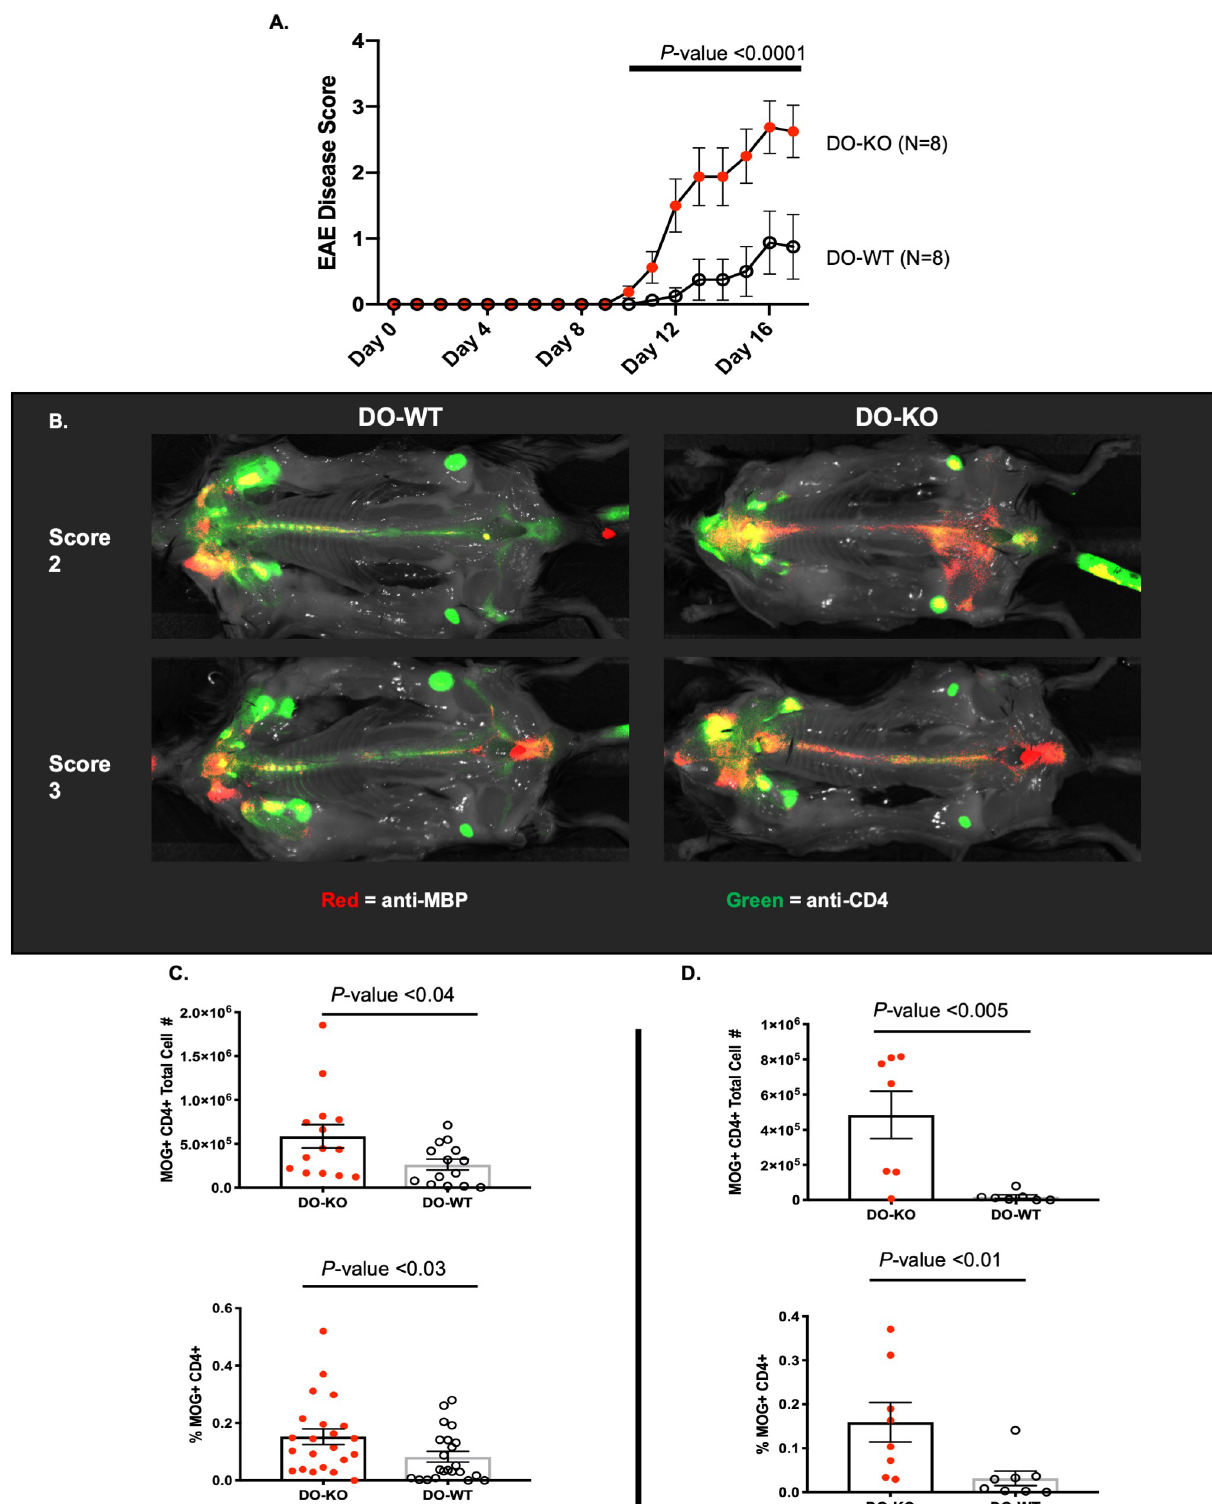
Fig 7. Accelerated EAE disease onset and increased recovery of MOG(38–51)/I-A b tetramer positive CD4 T cells from the CNS tissue of DO-KO mice. (A) Representative curves showing the time course of disease development in DO-KO (red) and DO-WT mice (white). N = 5 mice per group, representative of > 15 repeat experiments. Score system: 0 = no symptoms, 1 = limp tail, 2 = limp tail + partial hind limb paralysis, 3 = limp tail + total